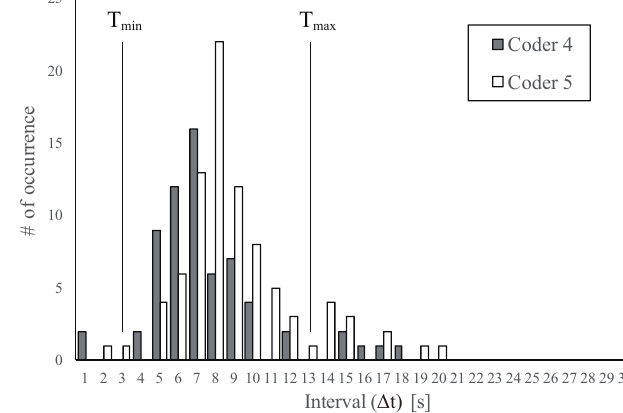
Figure 5. Length of the time intervals between the messages exchanged during turn-taking